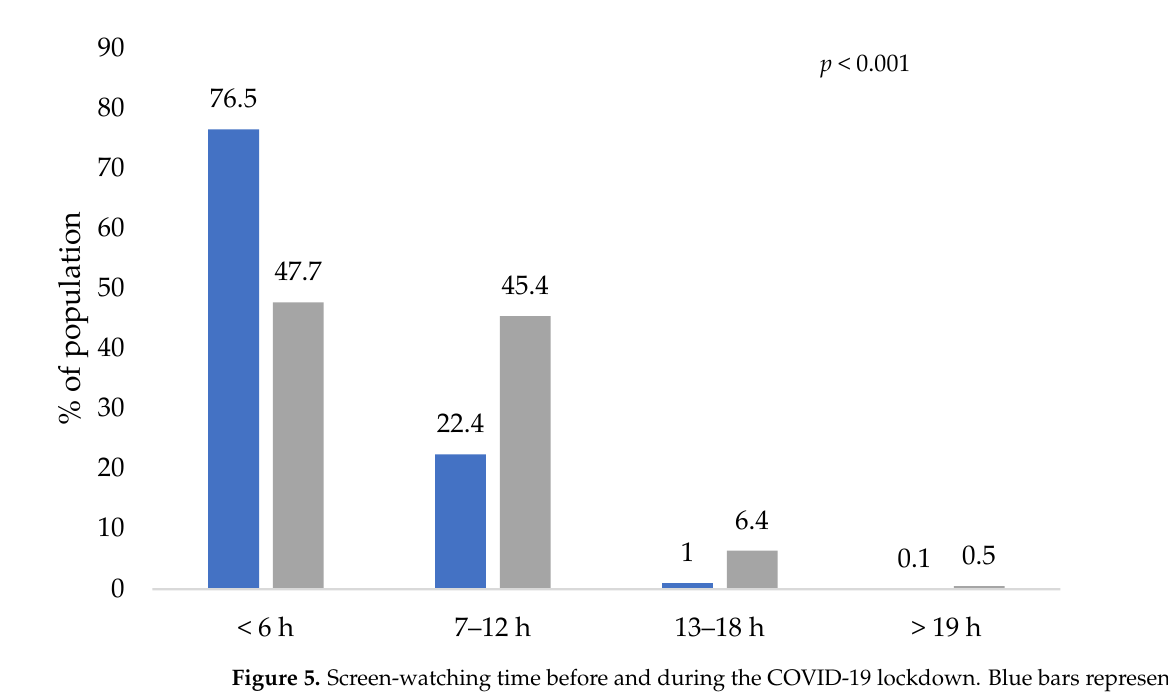
Figure 5. Screen-watching time before and during the COVID-19 lockdown. Blue bars represent the activity of participants before the lockdown and gray bars represent the activity during the lockdown.